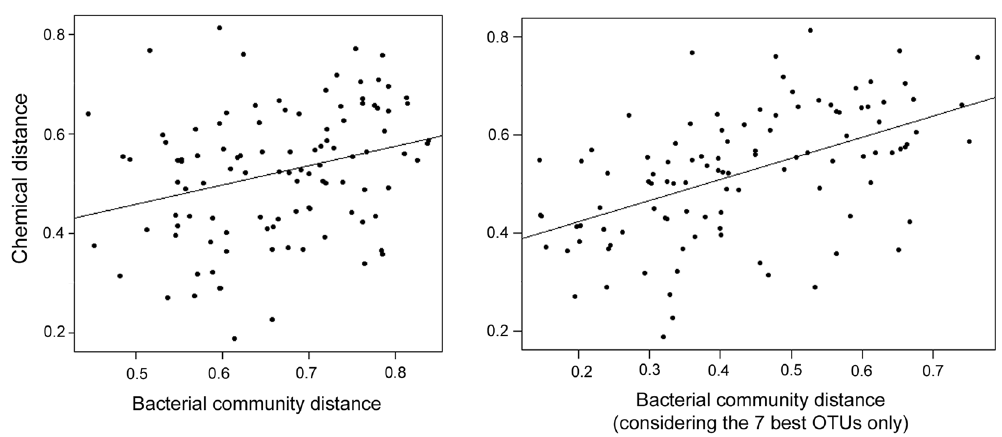
Figure 7. Chemical distance in relation to bacterial distance in male meerkat anal paste mixtures. Bacterial distance was calculated using ( a ) all OTUs or ( b ) the 7 OTUs that best explained the males’ chemical